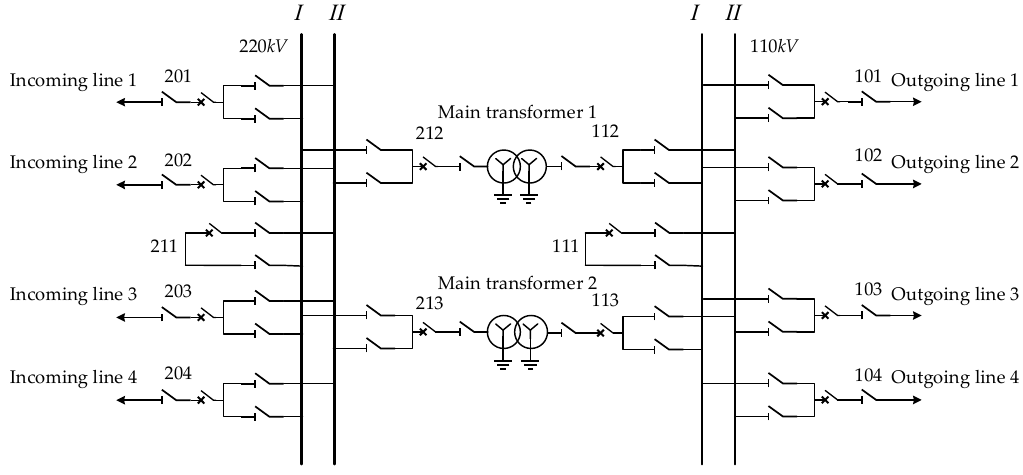
Figure 8. Main wiring diagram of 220 kV smart substation.